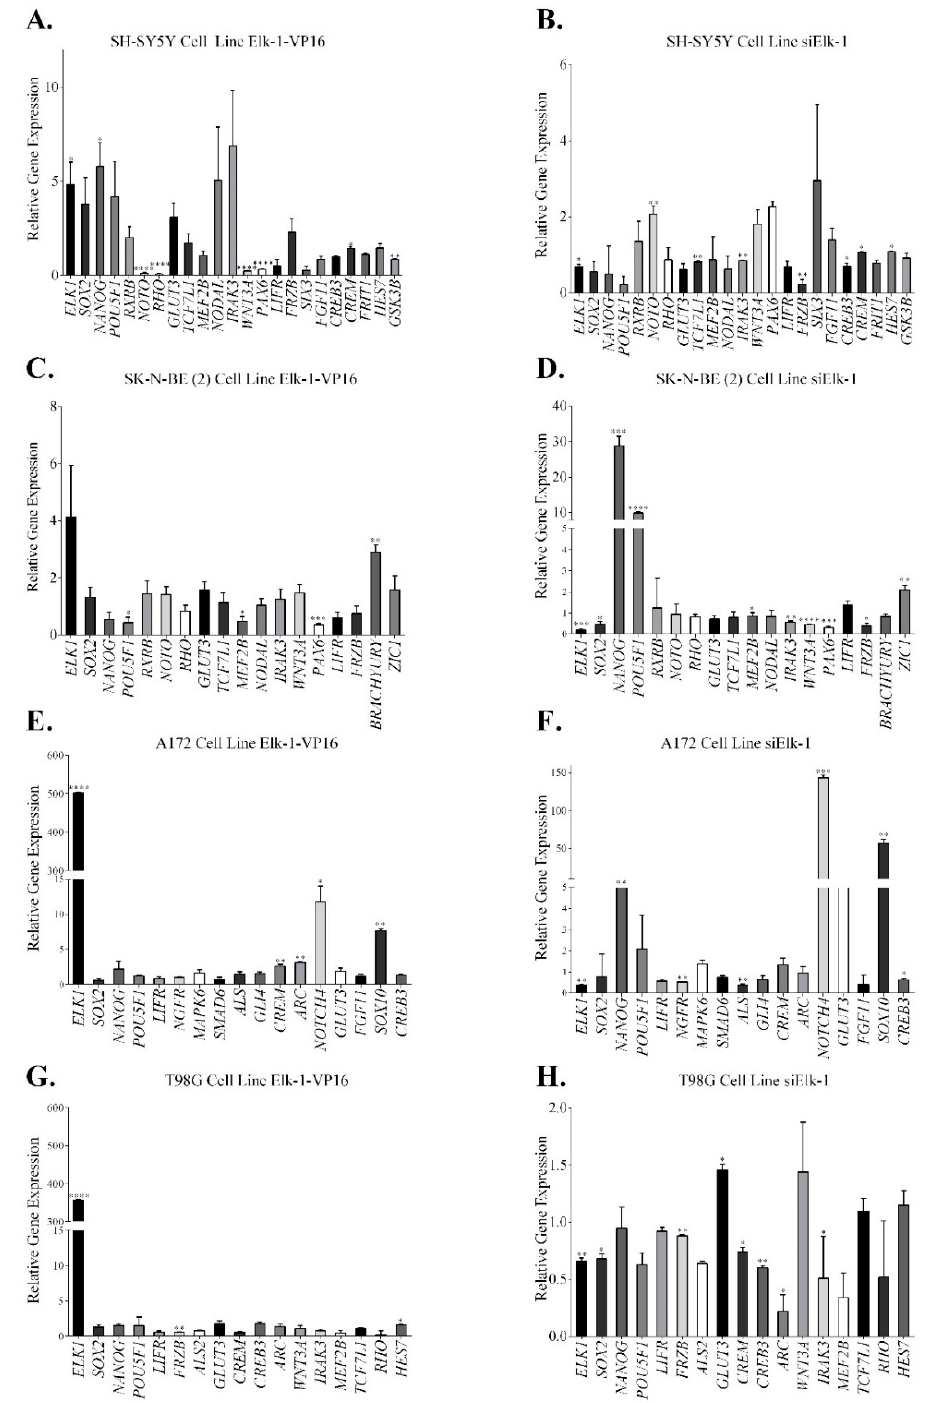
Figure 2. qPCR expression profiles of selected genes in different cell lines upon overexpression of Elk-1-VP16 ( A , C , E , G ) or knockdown of endogenous Elk-1 ( B , D , F , H ). Expression profiles after ( A ). over-expression with Elk1-VP16 and ( B ). after knock-down with siElk1 in SH-SY5Y neuroblastoma cell line; expression profiles after ( C ). over-expression with Elk1-VP16 and ( D ). after knock-down with siElk1 in SK-N-BE(2) neuroblastoma cell line; expression profiles after ( E ). over-expression with Elk1-VP16 and ( F ). after knock-down with siElk1 in A172 GBM cell line; expression profiles after ( G ). over-expression with Elk1-VP16 and ( H ). after knock-down with siElk1 in T98G GBM cell line. Unpaired t-test; **** p < 0.0001, *** p < 0.001, ** p < 0.01, * p < 0.05.